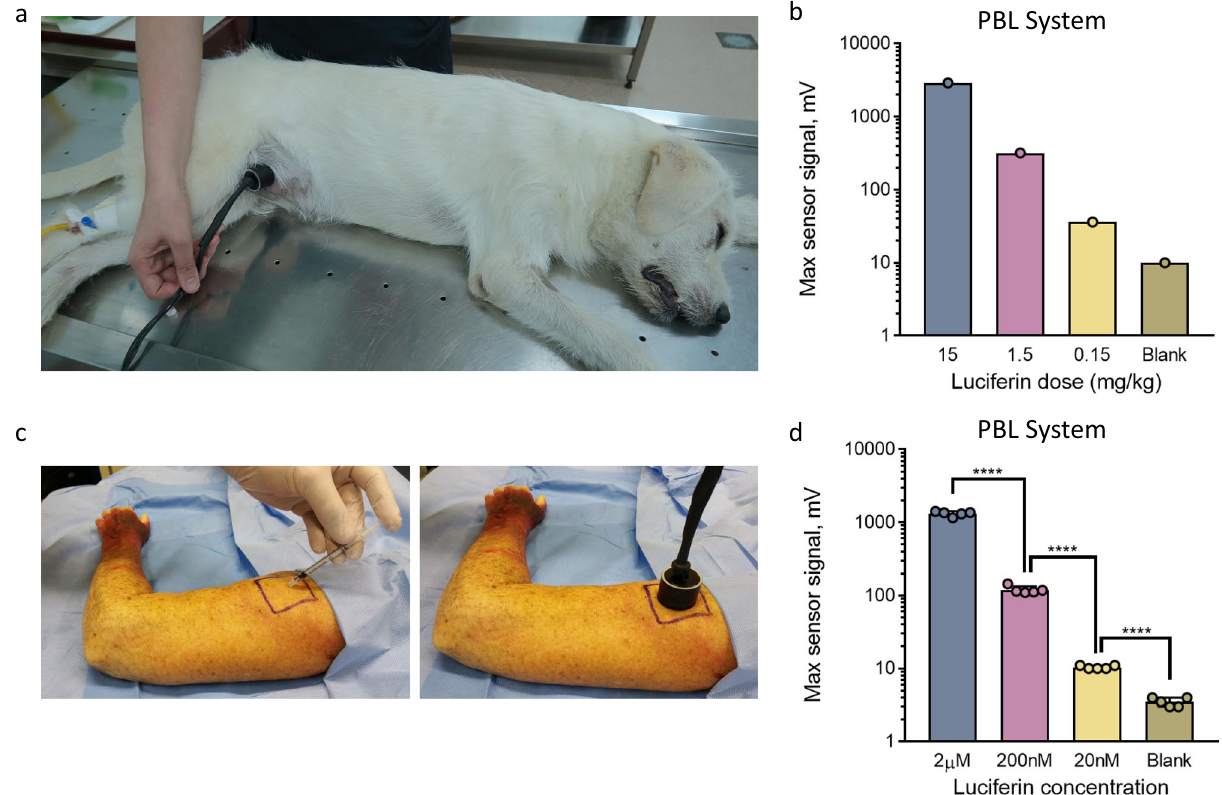
Fig. 5 Noninvasive BL signal quanti fi cation in large animals (dogs) and a human post-mortem model using the PBL method. a Experimental setup for the application of the PBL method in dogs. Three large dogs were anesthetized followed by s.c. injection of 0.5 mL of the luciferase plug in the abdominal area followed by i.p. injection of 5 mL of luciferin solution at three different concentrations (15 mg/kg, 1.5 mg/kg and 0.15 mg/kg). The portable light detector is then placed on the area of the luciferase plug, and measurements are obtained for 30 min following the luciferin injection. The experiment was performed as a proof of principle with n = 1 for each time point with one luciferin injection per dog. b Maximal signal output obtained from dogs injected with different concentrations of luciferin (15, 1.5 and 0.15 mg/kg in 5 mL of PBS). c Experimental setup for PBL measurements in a human post-mortem model. The luciferase plug matrix was premixed with three different doses of luciferin (2 µ M, 200 nM and 20 nM) followed by direct s.c. injection of the 100 µ L of the activated luciferase plug under the skin of a human cadaver. The portable light detector was assembled directly on top of the plug followed by signal acquisition for 15 min. Three independent injections were performed for each luciferin concentration. d Average maximal signal output obtained by the portable light detector in the experiment described in ( c ). Statistical signi fi cance (**** P < 0.0001) was calculated using a two-tailed unpaired t -test. Source data is available as a Source Data fi le for ( b and d